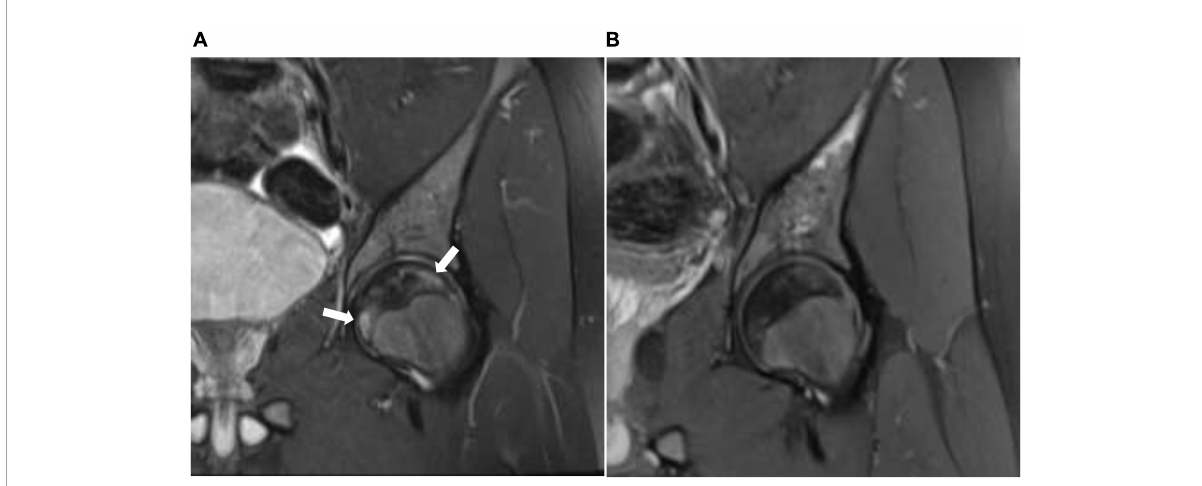
FIGURE2 (A) Coronal STIR (short T1 inversion recovery) of the left hip before treatment with HBO showing geographic subarticular area of high-signal intensity (arrows) with no collapse of the head of the femur (stage II). (B) Coronal STIR (short T1 inversion recovery) of the left hip after treatment showing complete resolution of the previously seen subarticular high-signal intensity suggests complete radiological resolution of avascular necrosis.